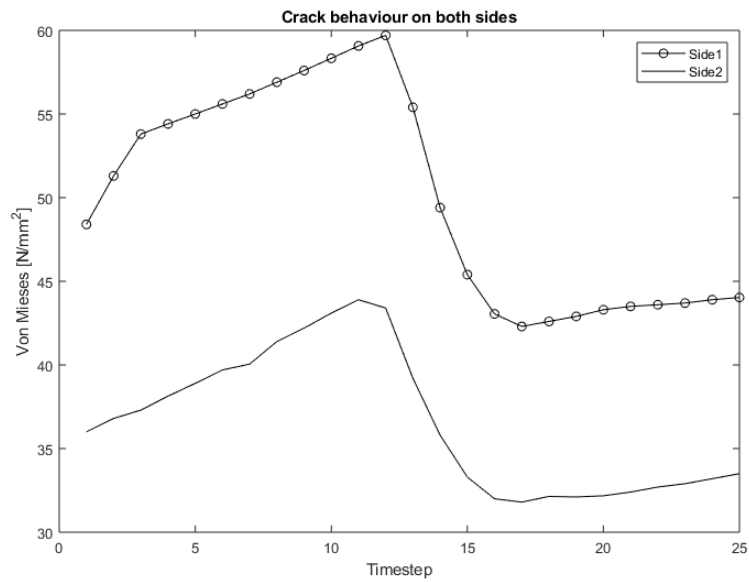
Figure 11. Comparison of sides 1 and 2 with the crack.